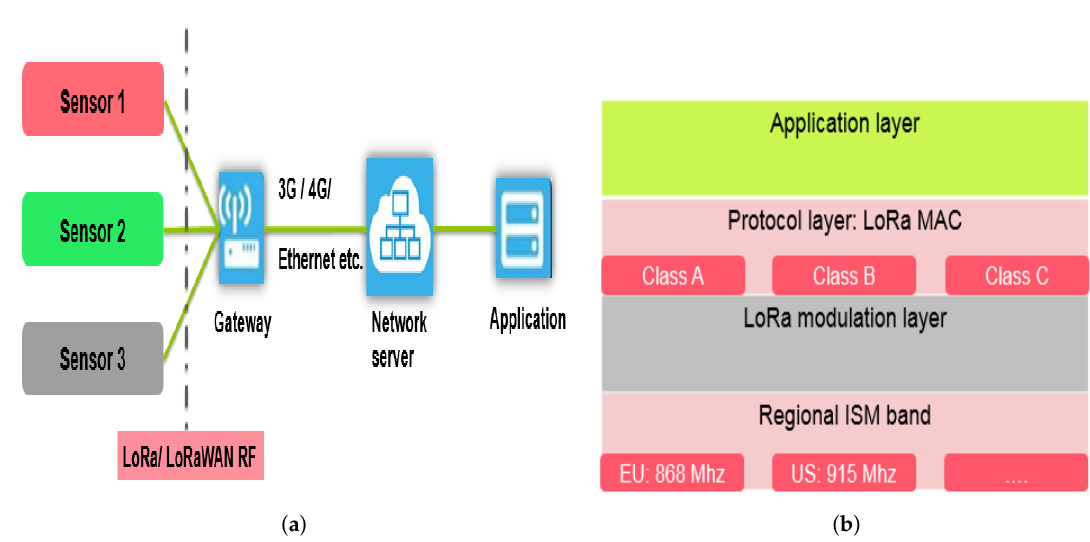
Figure 3. ( a ) LoRaWAN network architecture; and ( b ) LoRaWAN protocol stack.